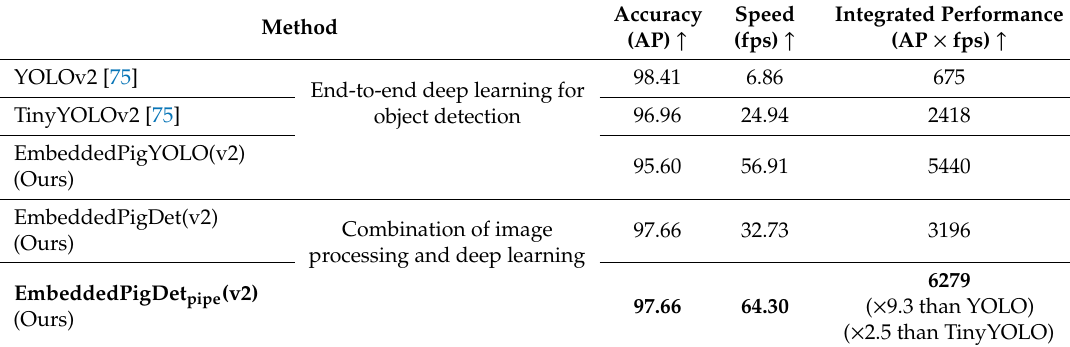
Table 5. Comparison of average performance on a